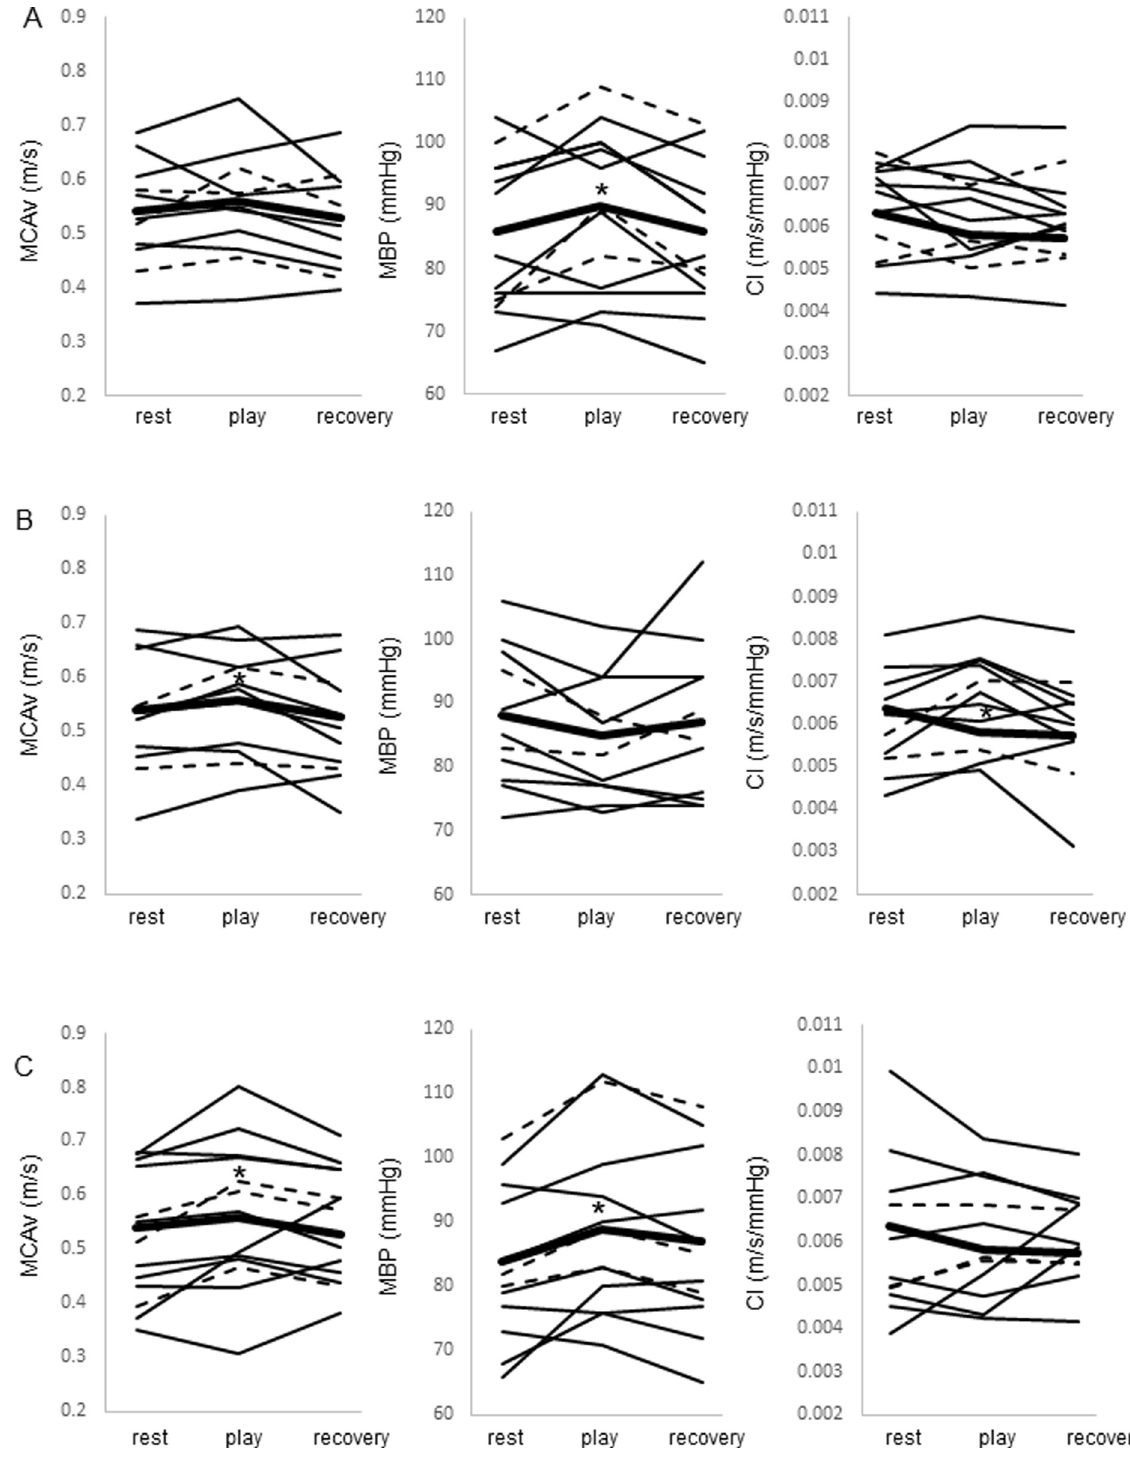
Fig 1. Mean values for all subjects, and individual values for piano players and violin players. Middle cerebral artery blood flow velocity (MCAv), mean blood pressure (MBP) and conductance of MCAv (CI) before, during and after playing a musical instrument in (A) the first time look (FS) trial, (B) music already mastered (MS) trial and (C) music in practice (PR) trial. Shown are mean values for all subjects (thick black lines), and individual values for piano players (thin black lines) and violin players (dotted lines). � P � 0.05 vs. resting.